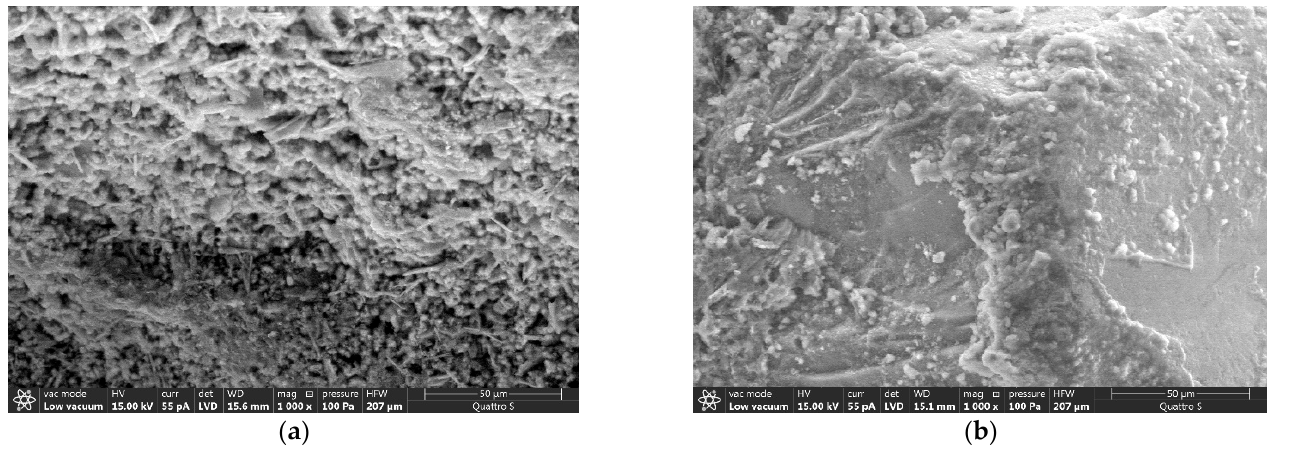
Figure 6. Microstructure of cement composite at 1000-fold magnification: ( a ) reference sample, ( b ) modified sample.